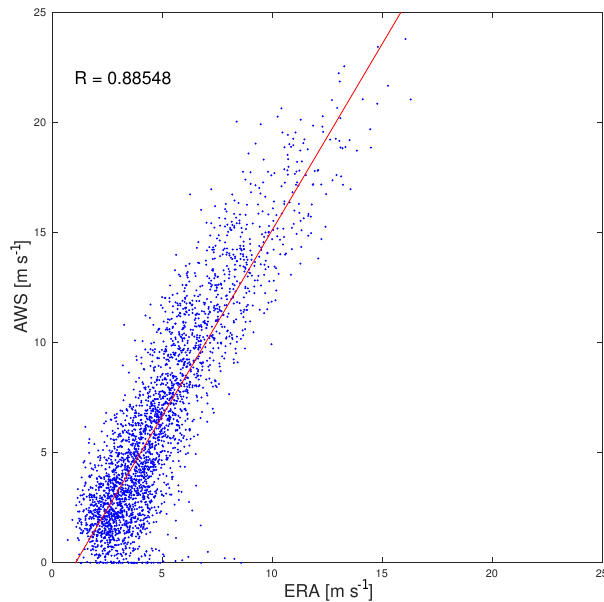
Figure 3. Scatter plot of 24h mean wind speed for winter 2000– 2014, measured by Laurie II AWS against that of ERA-Interim. The red line indicates the linear least squares